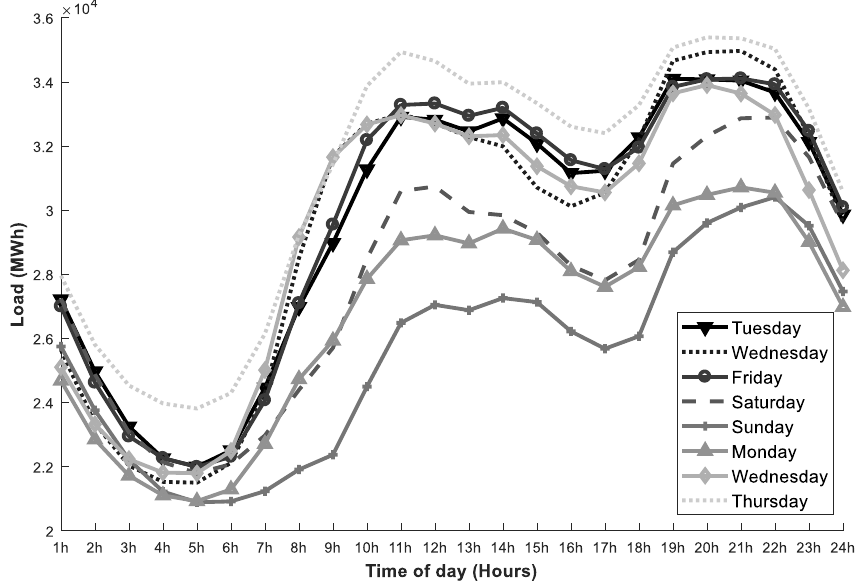
Figure 3. Hourly electricity demand for December 7th, which fell on Tuesday (2010), Wednesday (2011), Friday (2012), Saturday (2013), Sunday (2014), Monday (2015), Wednesday (2016) and Thursday (2017).